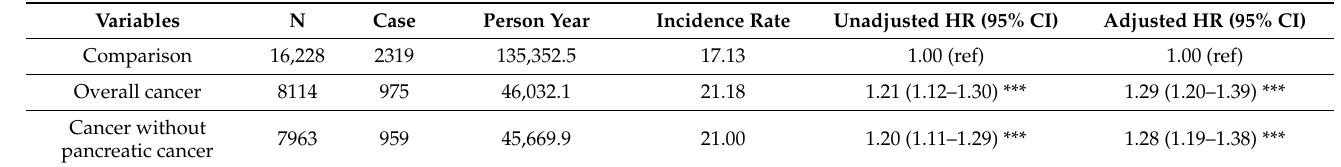
Table 1. Sensitivity analysis: incidence and risk of incident diabetes associated with cancer patients who excluded those diagnosed with pancreatic cancer.